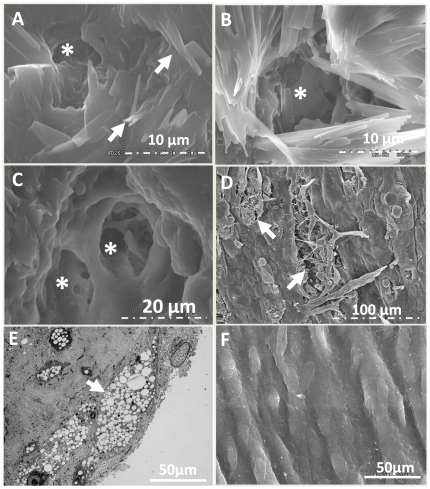
SEM images of rabbit aorta cholesterol plaque endothelium disruption.A: Speed vacuum dried, sputter coated SEM image of aortic endothelium of 12 month diet rabbit aorta demonstrating extensive superficial coating with crystalline structures (arrow) consistent with cholesterol that were not observed in standard ethanol dried preparations and similar to observations in human carotid endarterectomy samples made by Abela et al (see text). B: SEM images of speed vacuum dried cholesterol crystal around cavitary structure (*). C: Traditional dehydrated SEM image of cavitary structures (*) penetrating into subendothelial regions and surrounded by cholesterol crystals. D: Lower magnification SEM image with multiple endothelial erosions (arrow). E: TEM of endothelial foam cells (arrow) in cholesterol fed rabbit aorta sample. F: SEM image of normal aortic endothelium from regular diet rabbit for comparison.